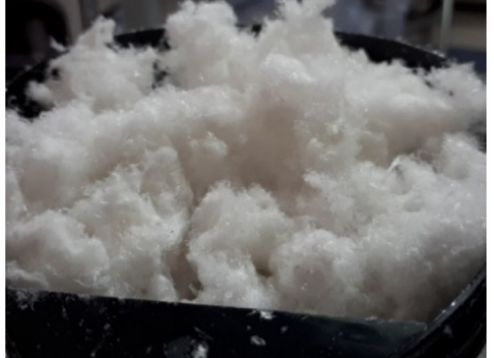
Figure 8. Hydrolyzed collagen obtained in the following conditions: type of enzyme: Papain; E/S: 1/20; time of hydrolysis: 0.5